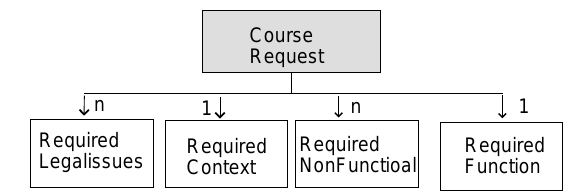
Figure 5. Course Request Structure requester and is defined in terms of the